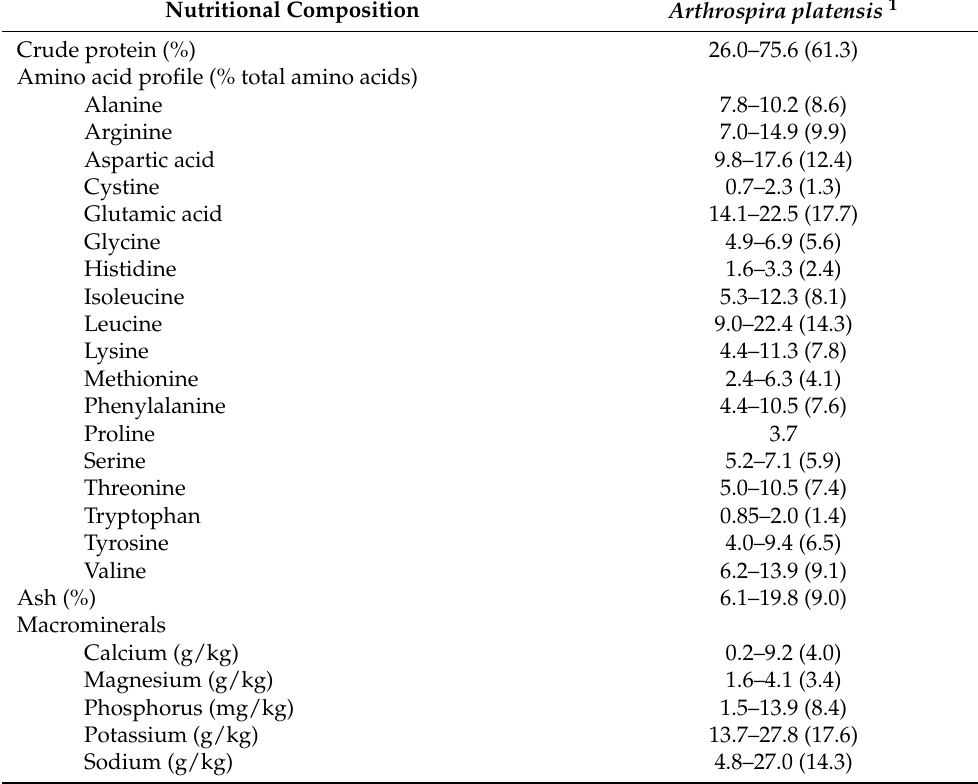
Table 1. Detailed nutritional composition of Arthrospira platensis (all values are expressed on a dry matter basis; hyphenated values are ranges based on several studies, and mean values are within